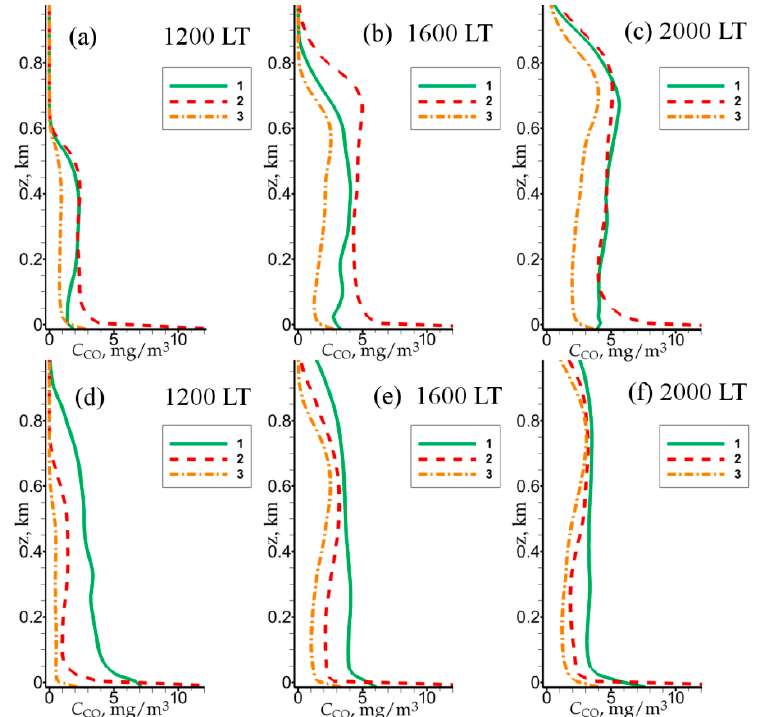
Figure 9. Vertical profiles of CO concentration, averaged over the cross-sections (along the lines 1, 2, 3 indicated in Figure 2a), at different diurnal phases. ( a – c ) Summer case; ( d – f ) Winter case.